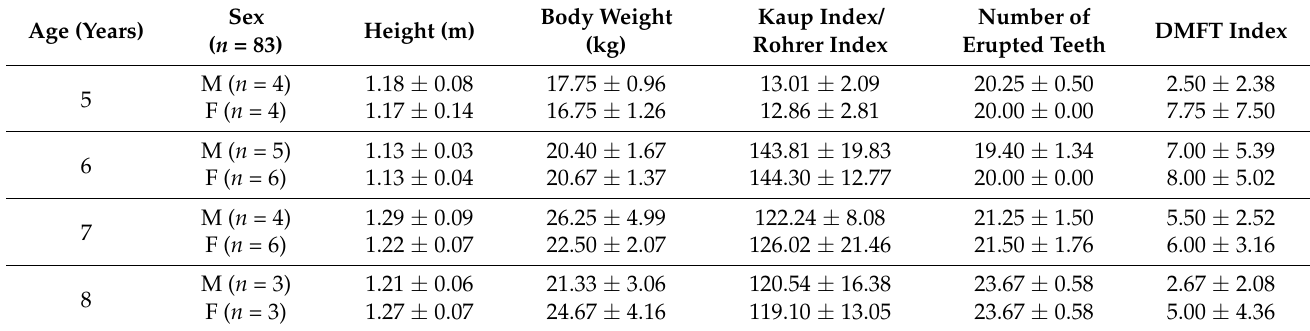
Table 1. Anthropometric parameters and dental examination results by age and